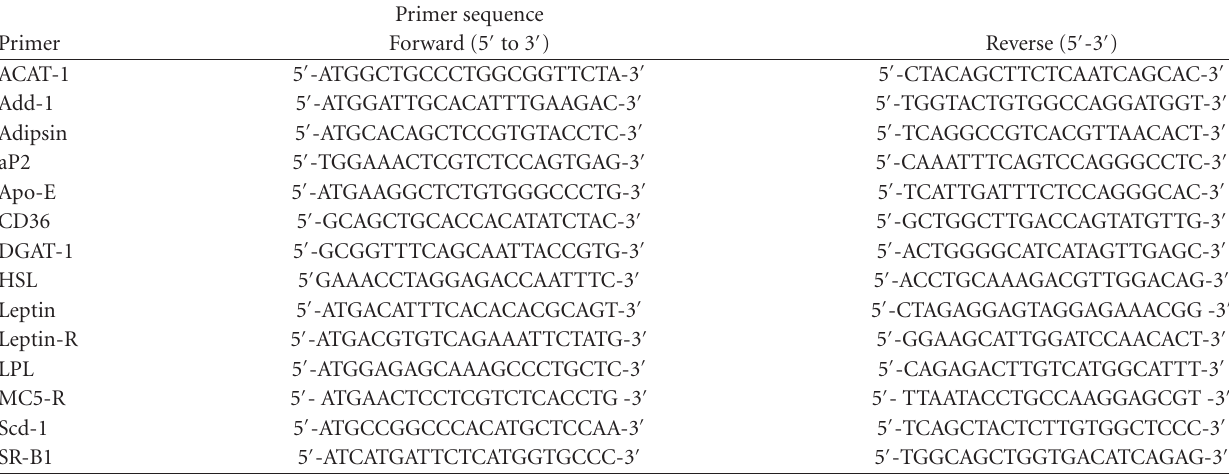
Table 1: Primers for RT-PCR.